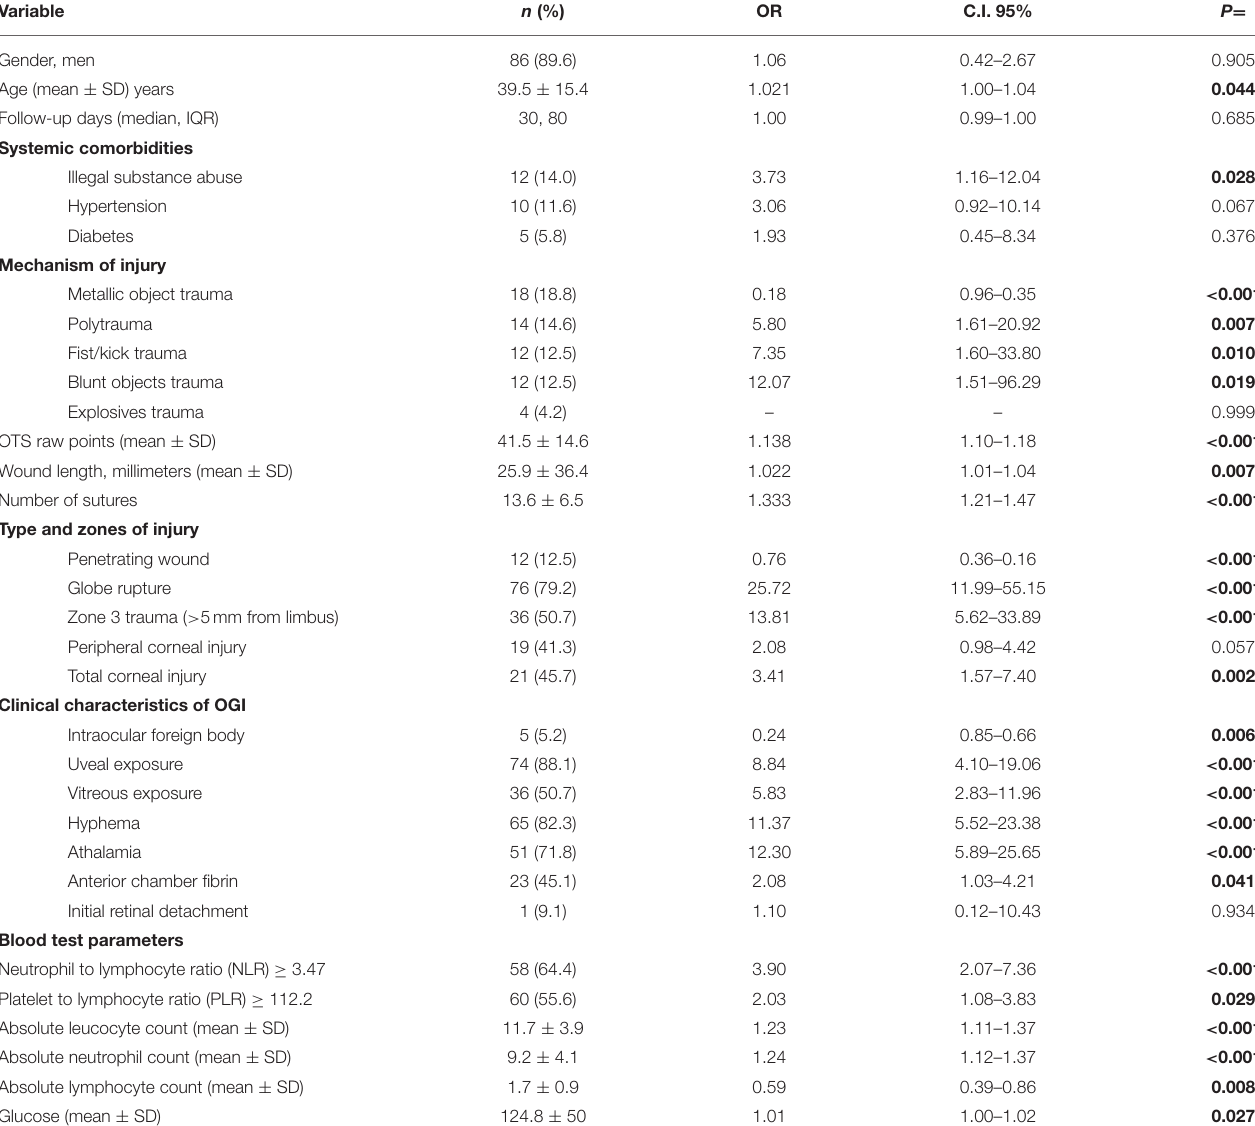
TABLE 6 | Univariate logistic regression analysis for severe visual impairment.